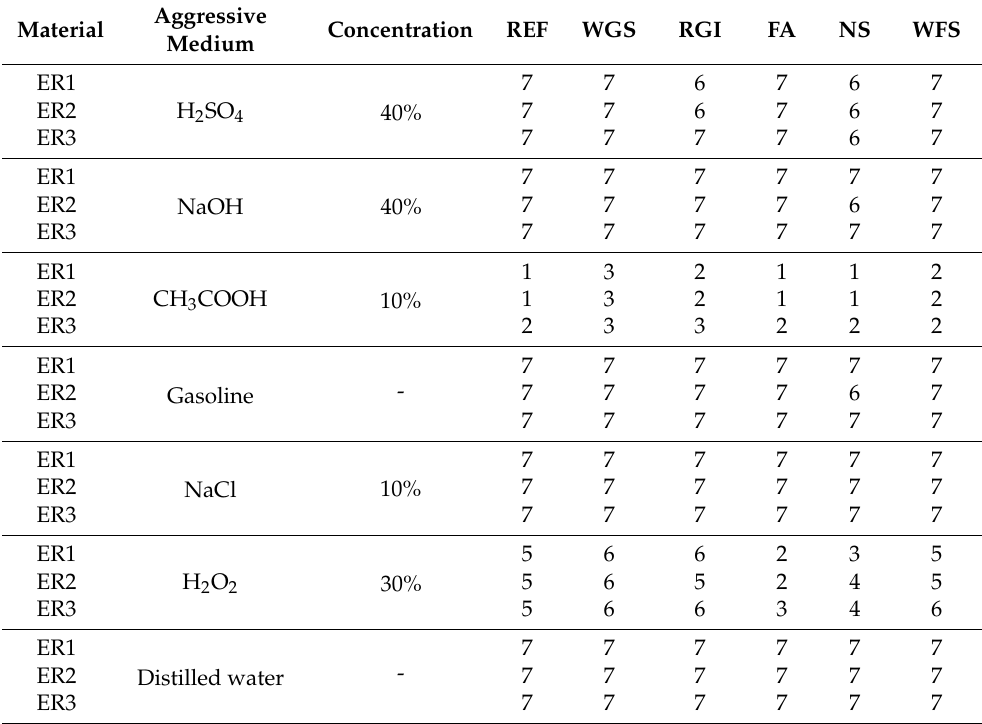
Table 6. Evaluation of the chemical